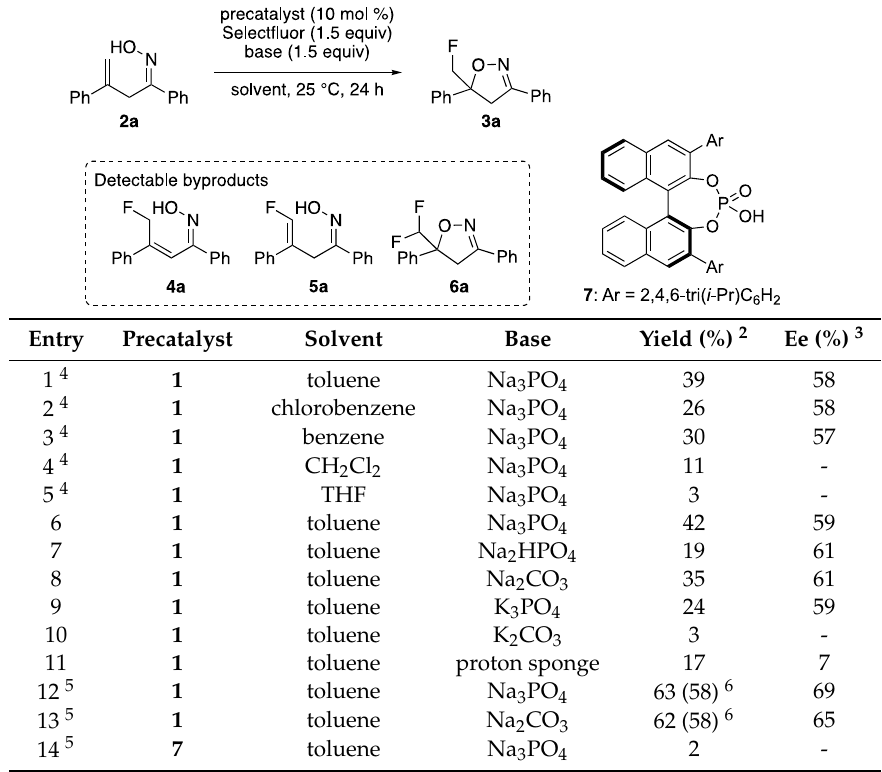
Table 1. Optimization of the reaction conditions. 1